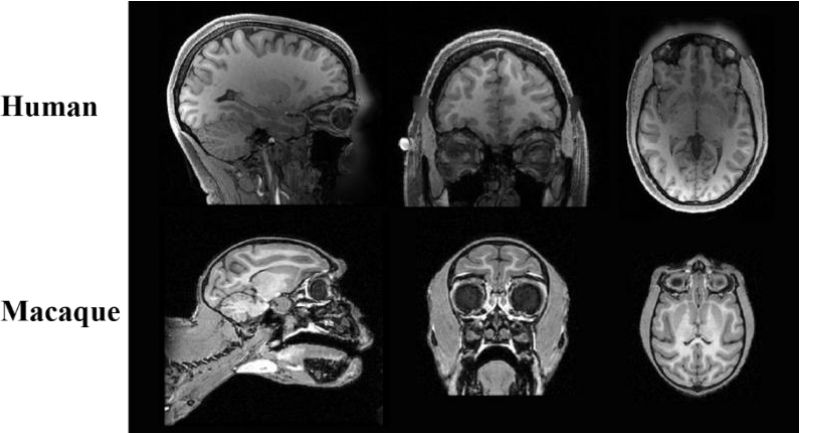
Figure 1. Schematic diagram of tissue structure difference between human and macaque brain in MRI.